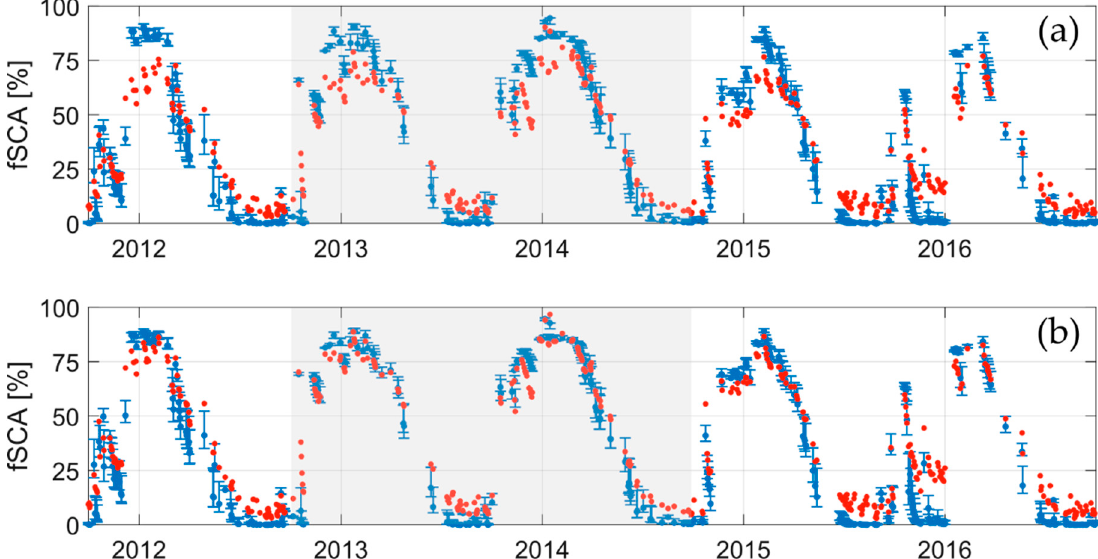
Figure 8. MODIS-based and TOPMELT fractional Snow-Covered Area (fSCA) estimated throughout the available period considering ( a ) the overall catchment and ( b ) the basin fraction matching the proposed criterion (i.e., open sites and forest sites with potential solar radiation larger than 17 MJ m − 2 d − 1 ). The grey shaded area represents the period over which the snow parameter estimation is performed (01 October 2012 to 30 September 2014).